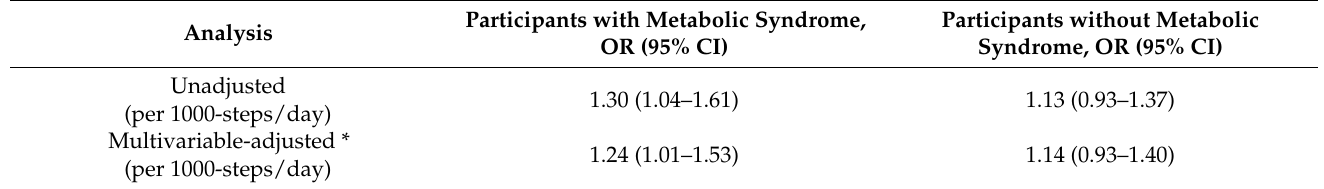
Table 3. Improvement in the number of metabolic syndrome components per 1000-steps/day